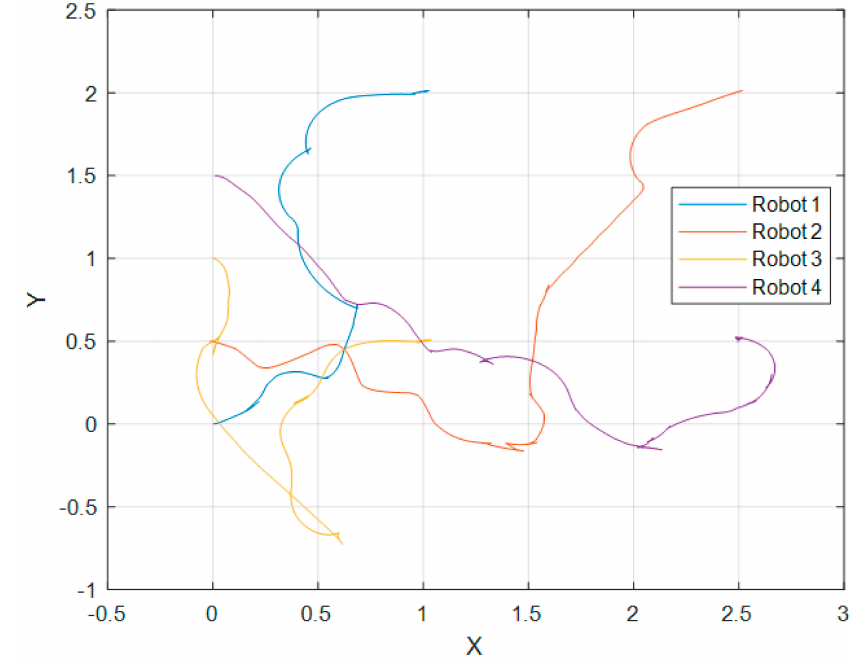
Figure 16. Trajectories in the 4-robot real-world test.